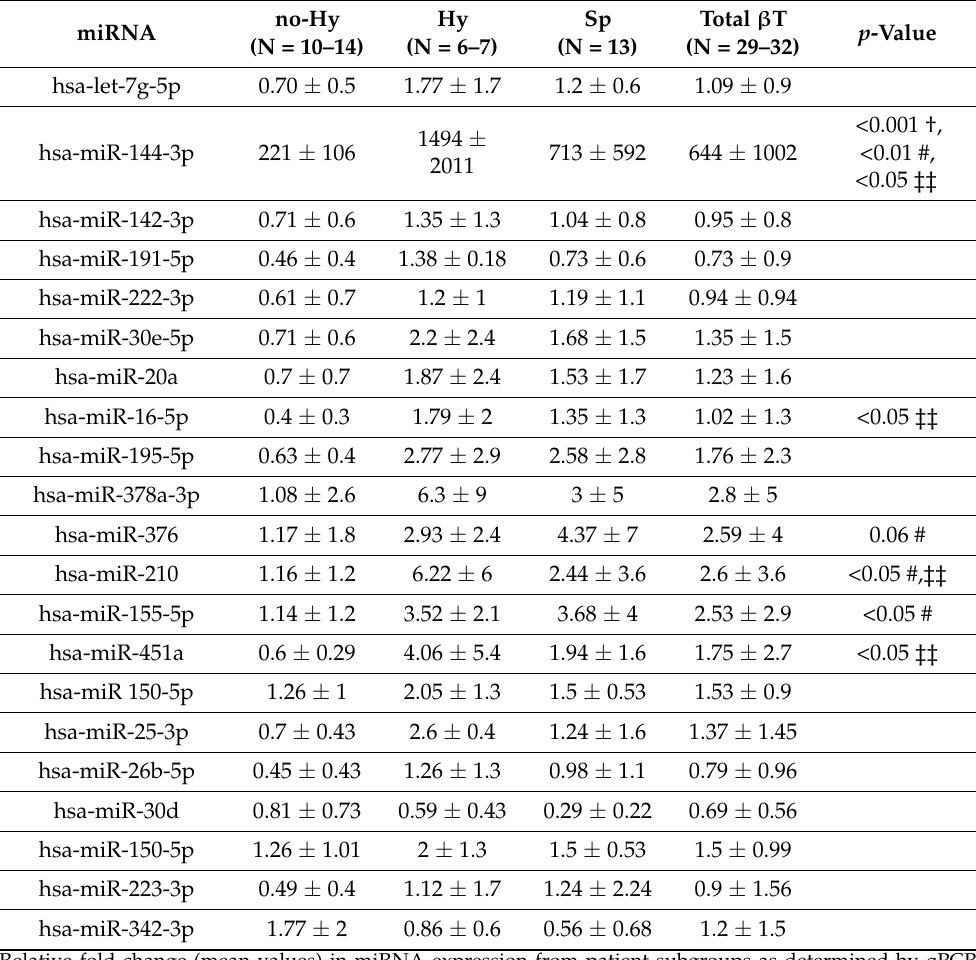
Table 2. Relative extracellular vesicle miRNA expression by RT-qPCR.